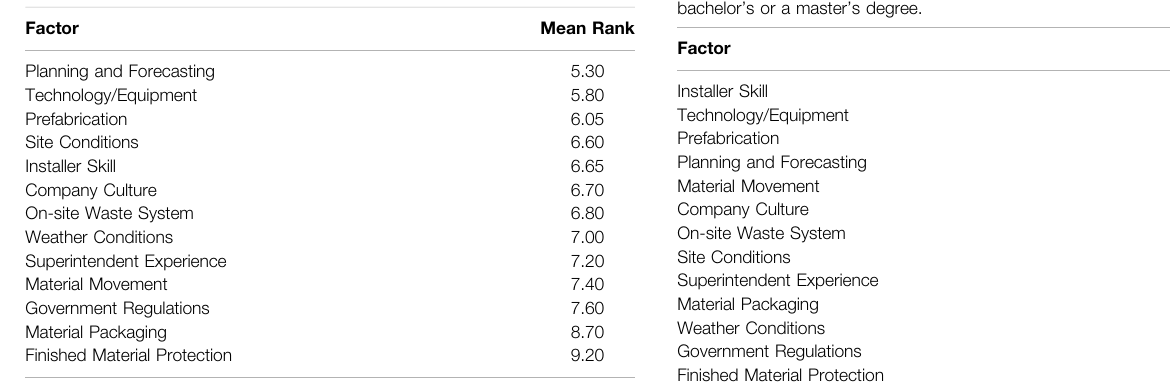
TABLE 7 | Mean ranks of the factors: seniors ’ responses.